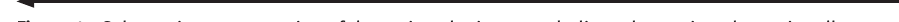
Figure 1: Schematic representation of the main selenium metabolic pathways in eukaryotic cells. From top to bottom, a Saccharomyces cerevisiae , higher plant and mammalian cell are represented with specific pathways highlighted in blue [yeast (31, 32)], green [plant (33–35)], and red [mammalian (36)] arrows. (1) Selenate is taken up by sulfate transporters and